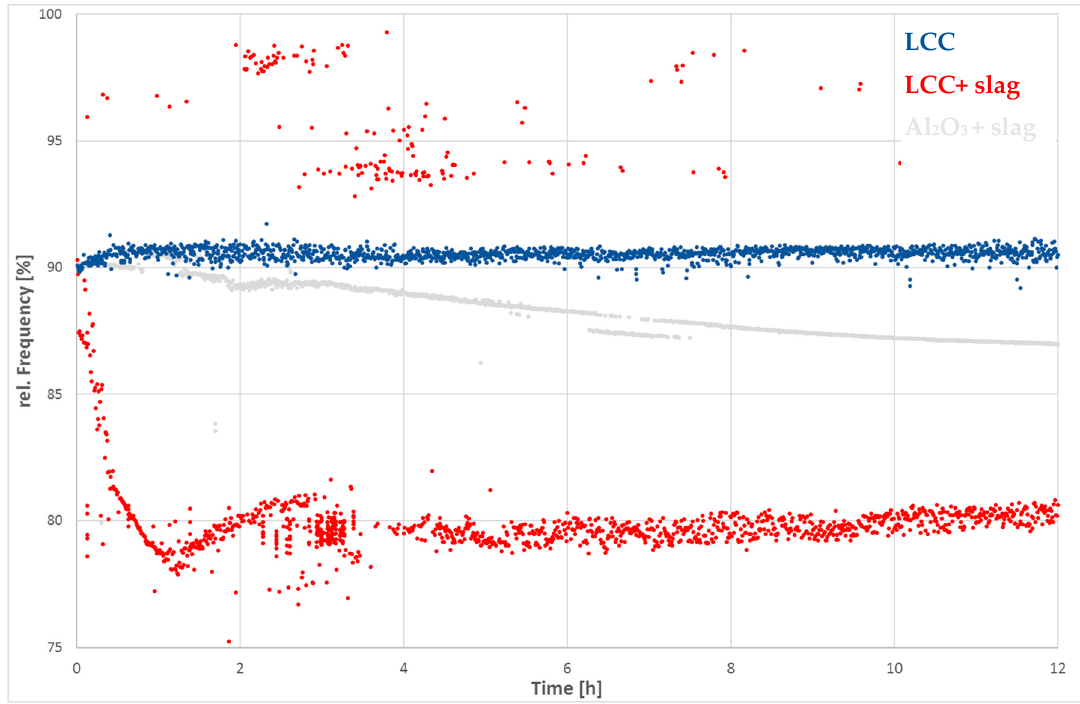
Figure 6. Relative change of frequency against time during the isothermal period of the reference LCC, the LCC and Alumina sample filled with slag, depicting different time-dependent corrosion behavior.